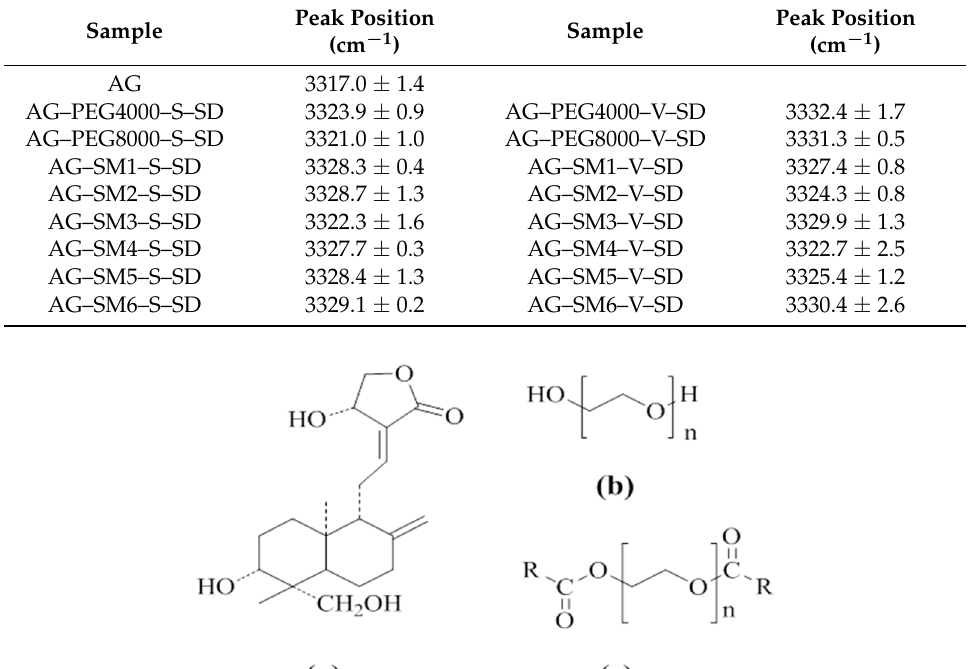
Table 1. –OH peak position of andrographolide in pure andrographolide (AG), and solid dispersion